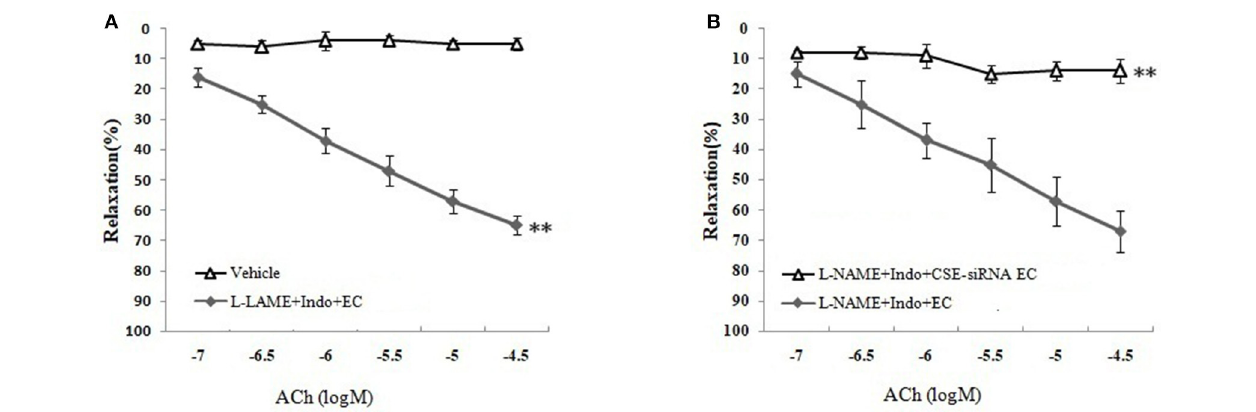
FIGURE 4 | Role of endothelial CSE in ACh-induced non-NO- non-PGI 2 relaxation in endothelium-denuded rat MCA (mean ± SD, n = 8). (A) Effect of EAhy926 cells (endothelial cell, EC) on ACh-induced non-NO- non-PGI 2 relaxation in KCl-preconstricted endothelium-denuded rat MCA. (B) Effect of EAhy926 cells with CSE